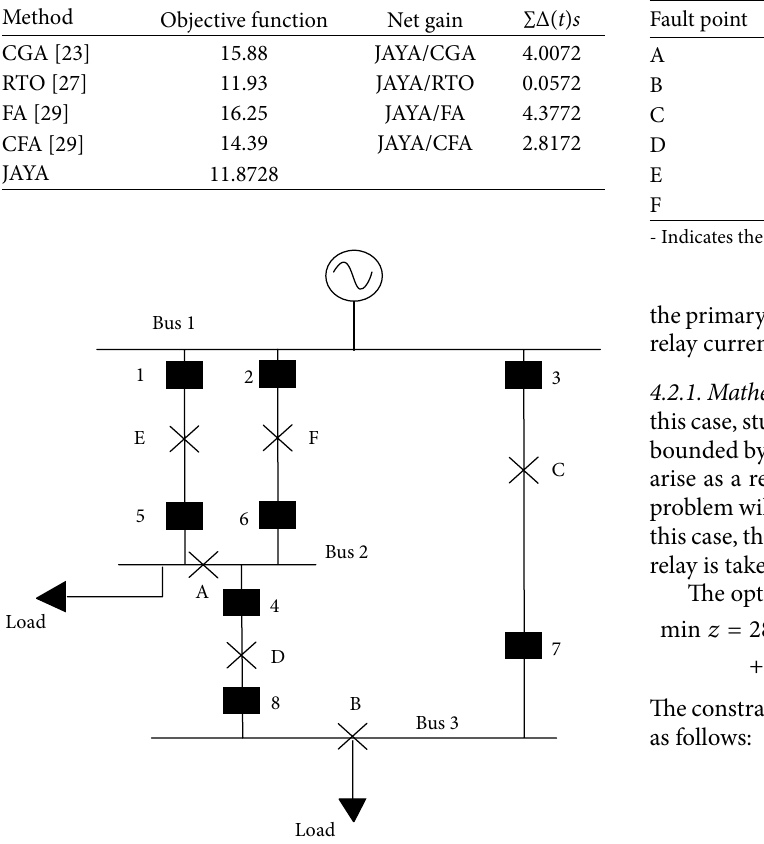
Figure 5: A multi-loop distribution system.